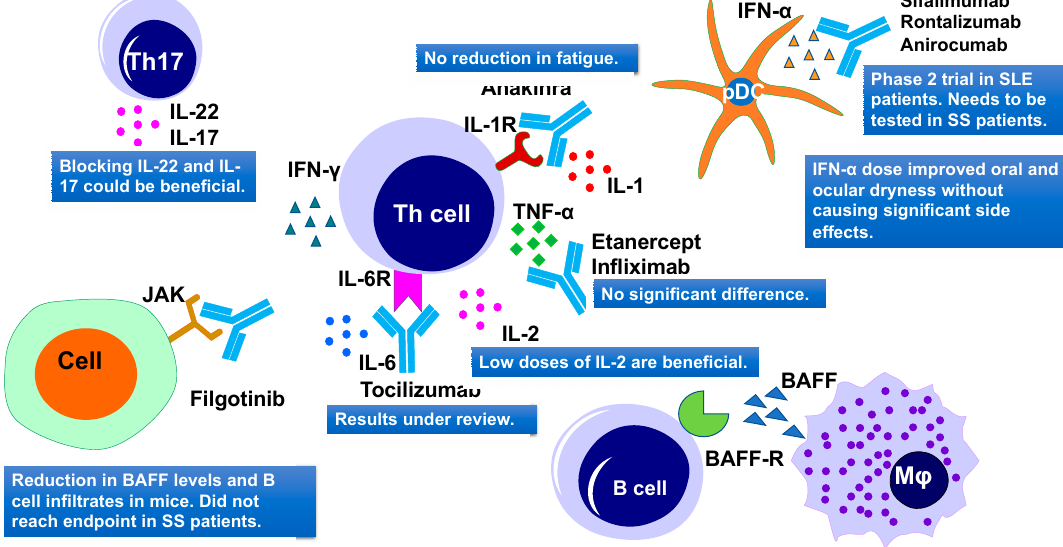
Figure 7. Cytokine-targeted therapies and their outcomes in primary Sjögren’s Syndrome. Current therapies include IL-1R, TNF- α , IL-6R, IL-2, JAK, IFN- α targeting. IL, interleukins; TNF- α , tumor necrosis factor– α ; IFN- α , interferon α ; and JAK, Janus